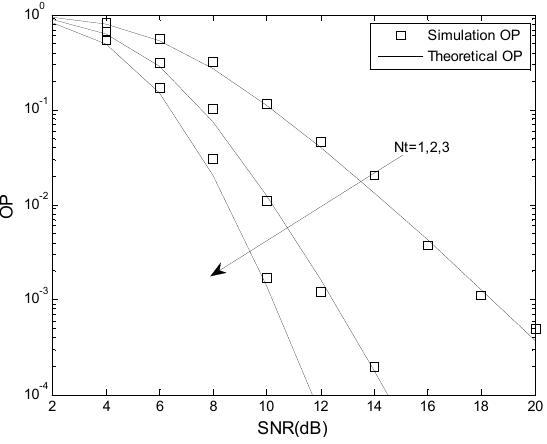
Figure 5. The OP performance of the optimal TAS scheme when th > P .